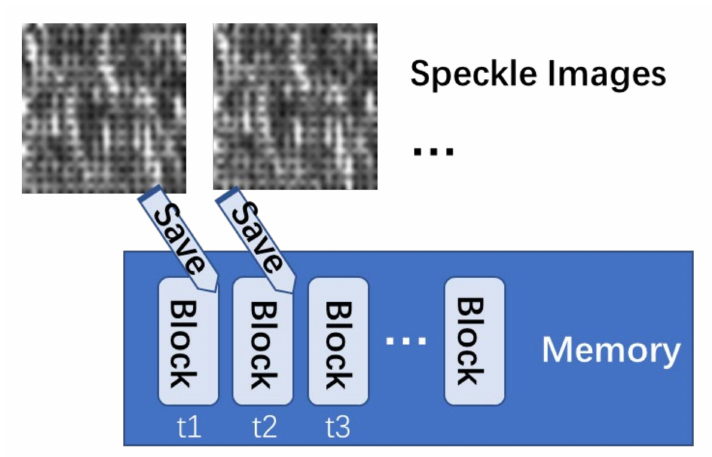
Figure 3. Diagram of fast image capture and storage process.